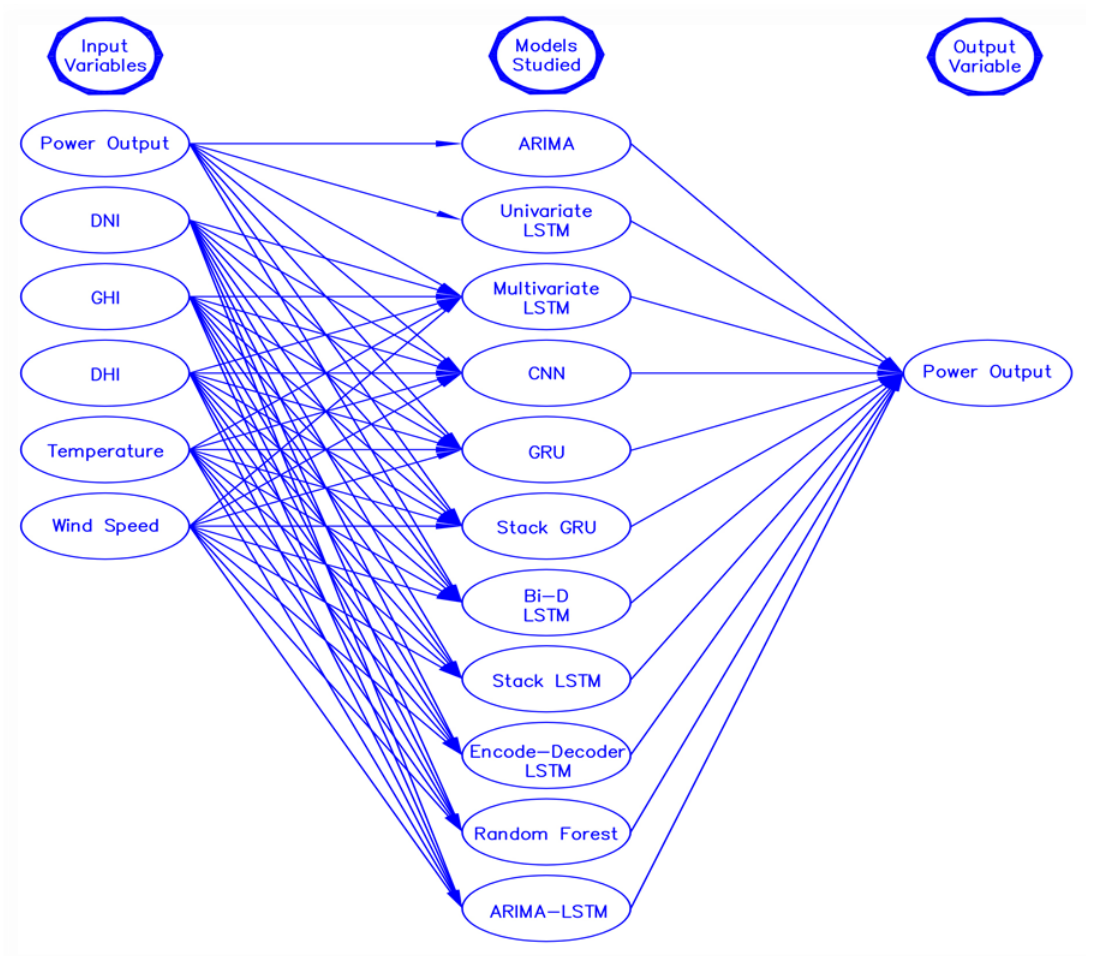
Figure 2. Input variables and models used in the study.